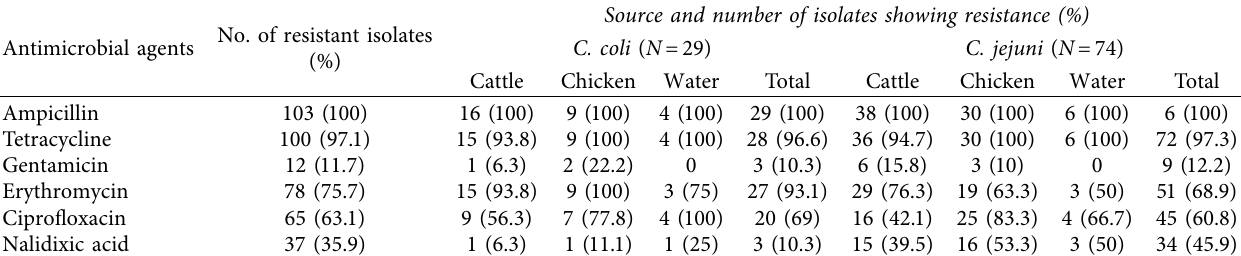
Table 2: Phenotypic antimicrobial resistance profles for C . coli and C . jejuni isolates. Source and number of isolates showing resistance No. of resistant isolates Antimicrobial agents (%)